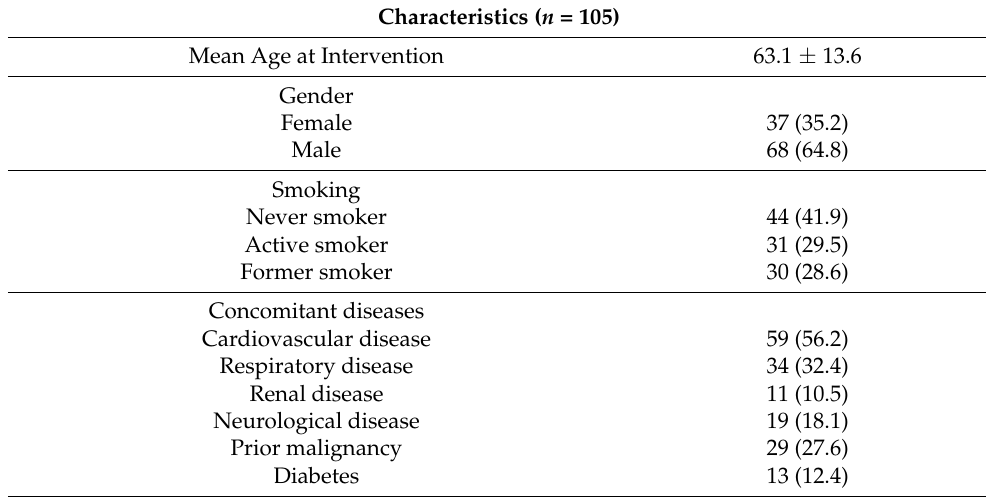
Table 2. Baseline characteristics. Data are presented as the mean ± SD or n (%).